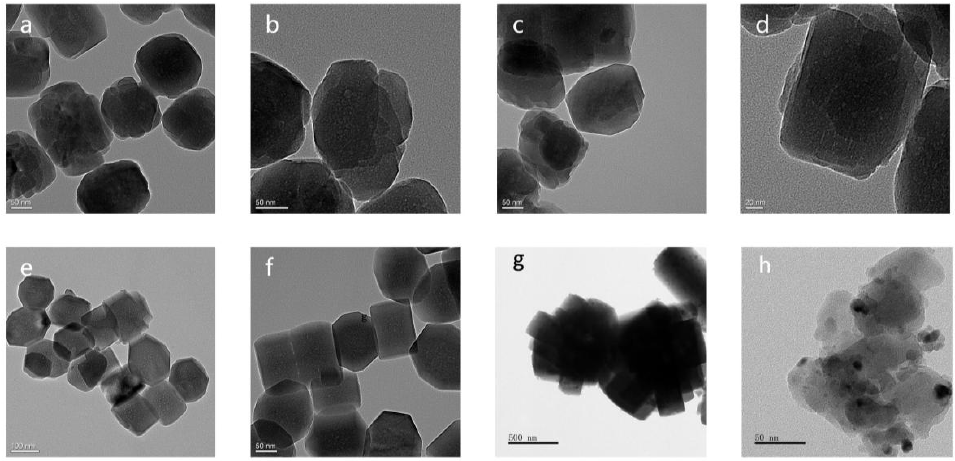
Figure 7. TEM images TS-1 ( a , b ), TS-1 used four times ( c , d ), S-1 ( e , f ), and commercial TS-1 ( g , h ).